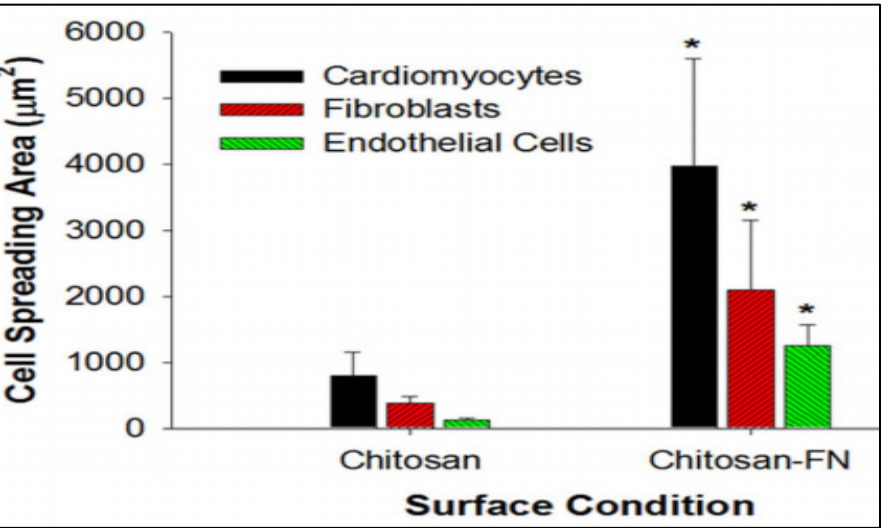
Figure 2. The comparison of the cardiomyocytes, fibroblasts, and endothelial cells spreading area on chitosan nanofibers immobilized with and without fibronectin. Immobilization of fibronectin enhanced the cellular spreading resembling the native heart tissue. Data are expressed as means SD. * p < 0.01 (chitosan vs. chitosan-FN). [26].